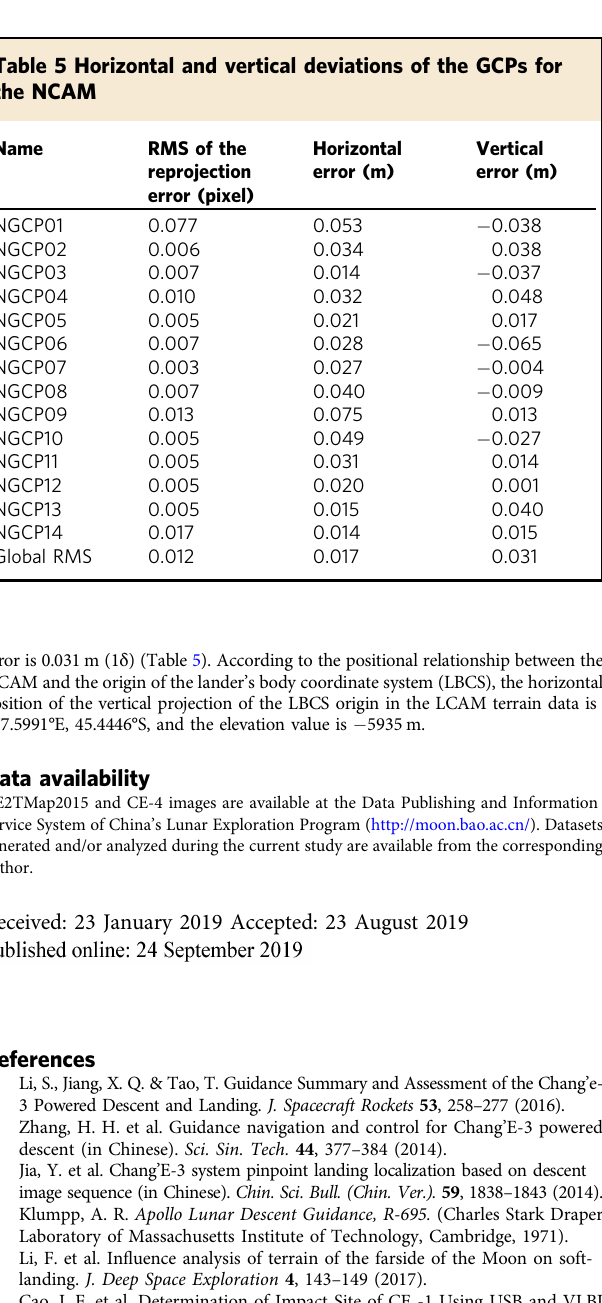
Fig. 9 Small rocks used as GCPs. a – d are stones in the NCAM image that can also be easily identi fi ed in the LCAM DOM